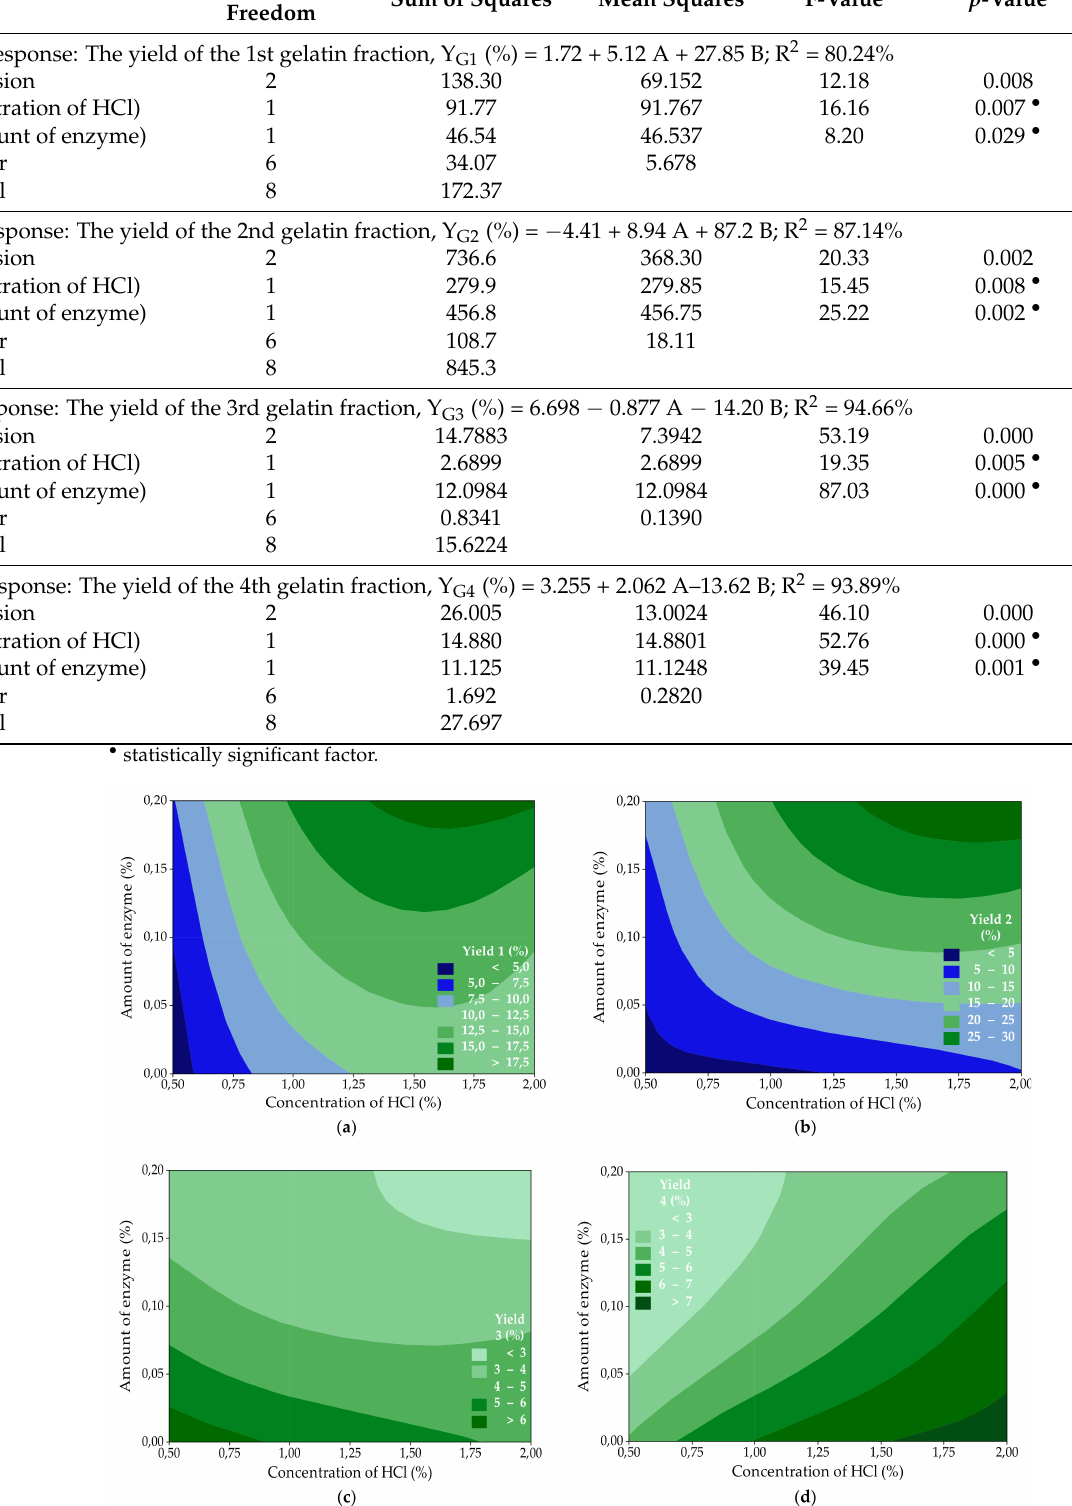
Table 2. Analysis of variance of the experimental design for gelatin yields. Degree of Sum of Squares Mean Squares F-Value p -Value Freedom